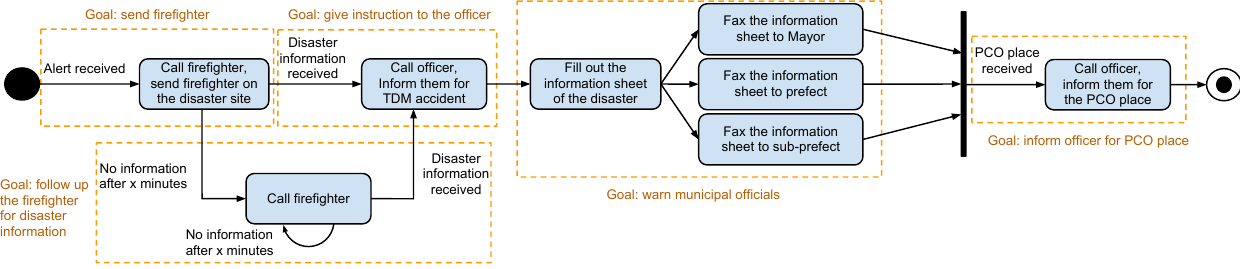
Figure 8. Codis activity